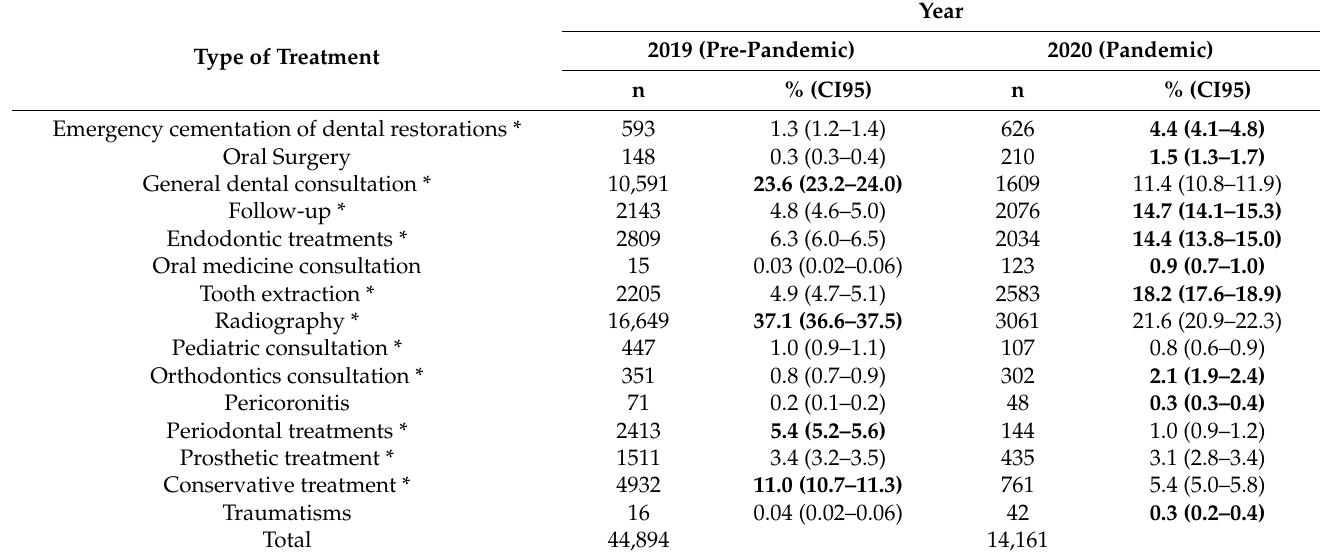
Table 4. Distribution of patients according to year of